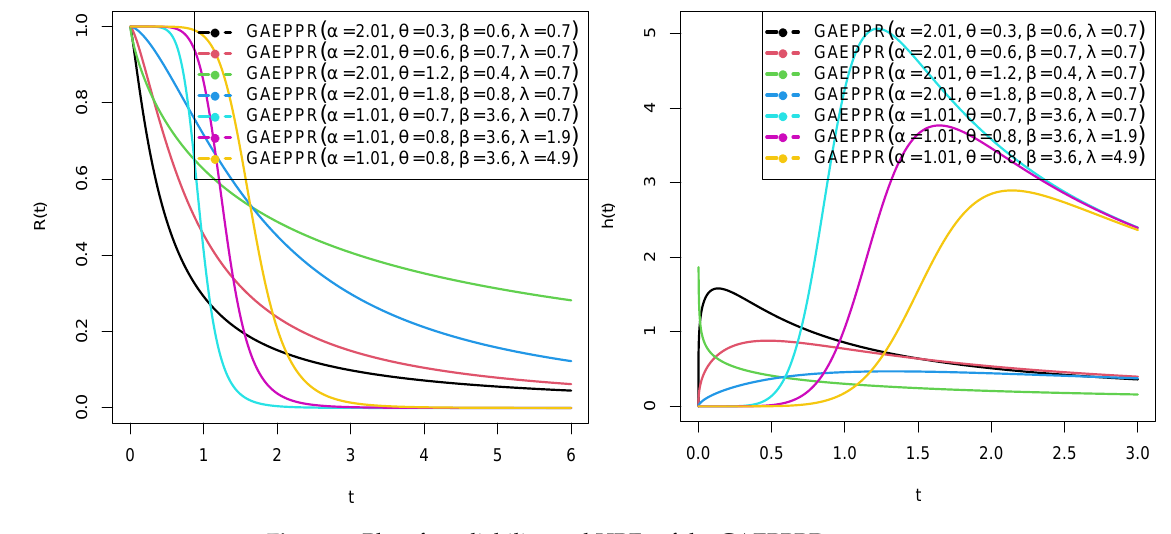
Figure 2. Plots for reliability and HRFs of the